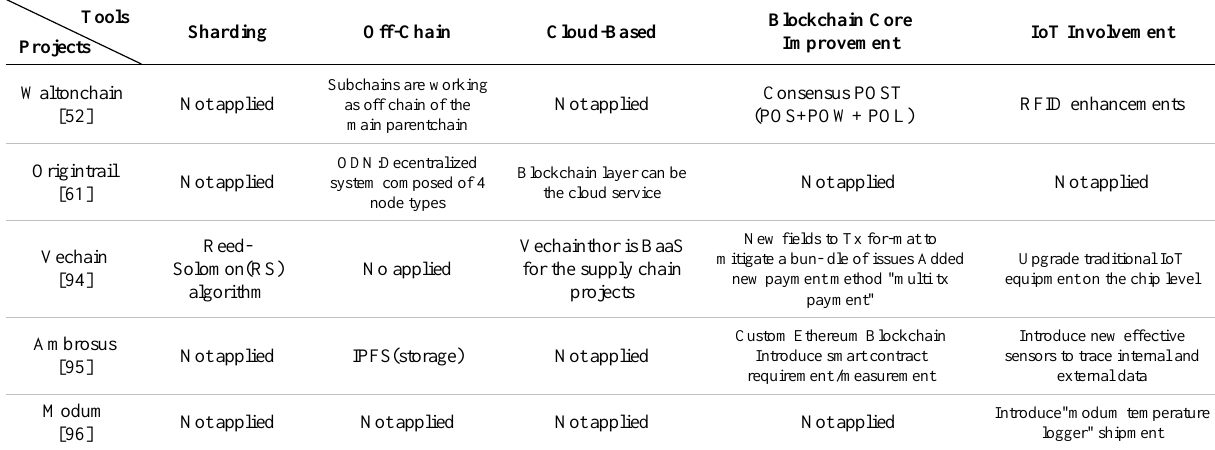
Table 4. Existing tools for the DLT-based supply